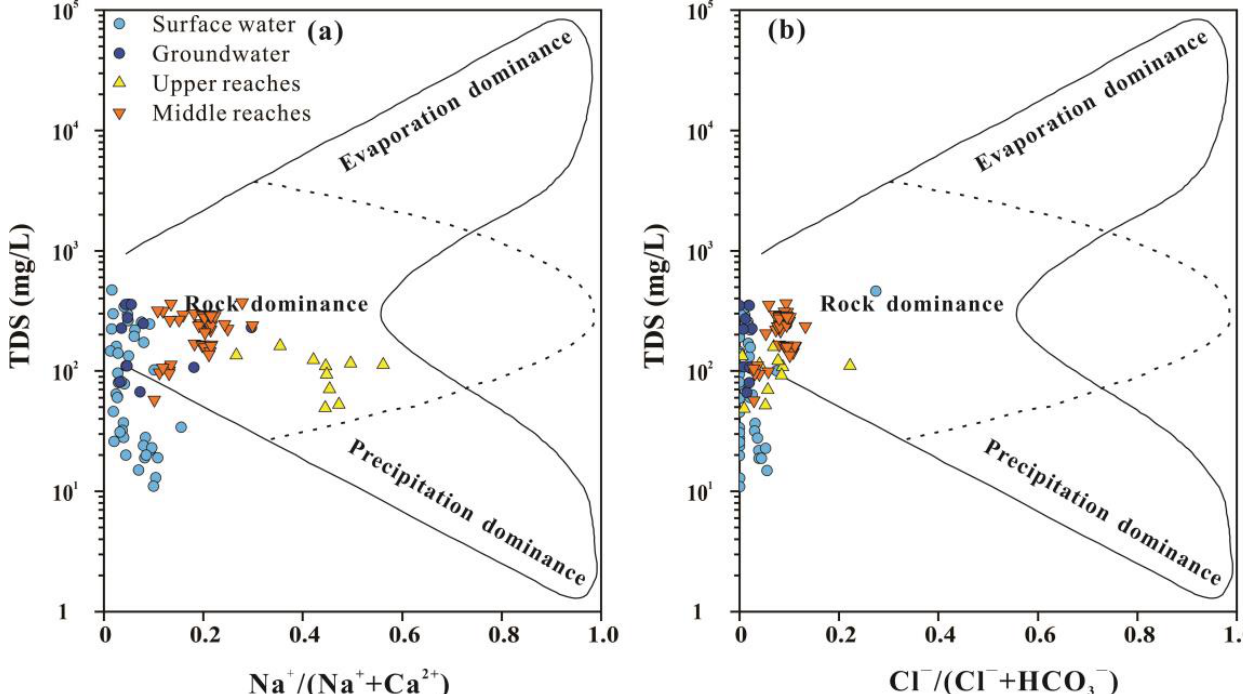
Figure 7. Gibbs diagram of the water resource in the Yarlung-Zangbo River. Data are from Tables 1 and 2.